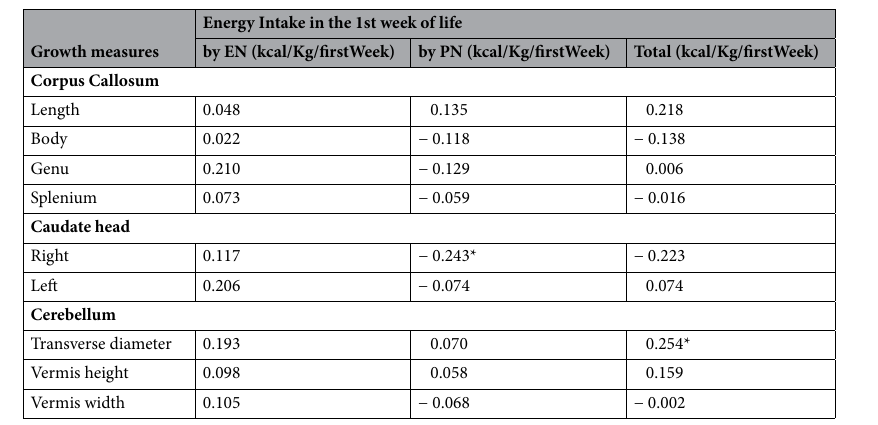
Table 2. Correlations between cerebral structures linear measures and energy intake. (T1 − T0)/T0. EN enteral nutrition, PN parenteral nutrition. * p <